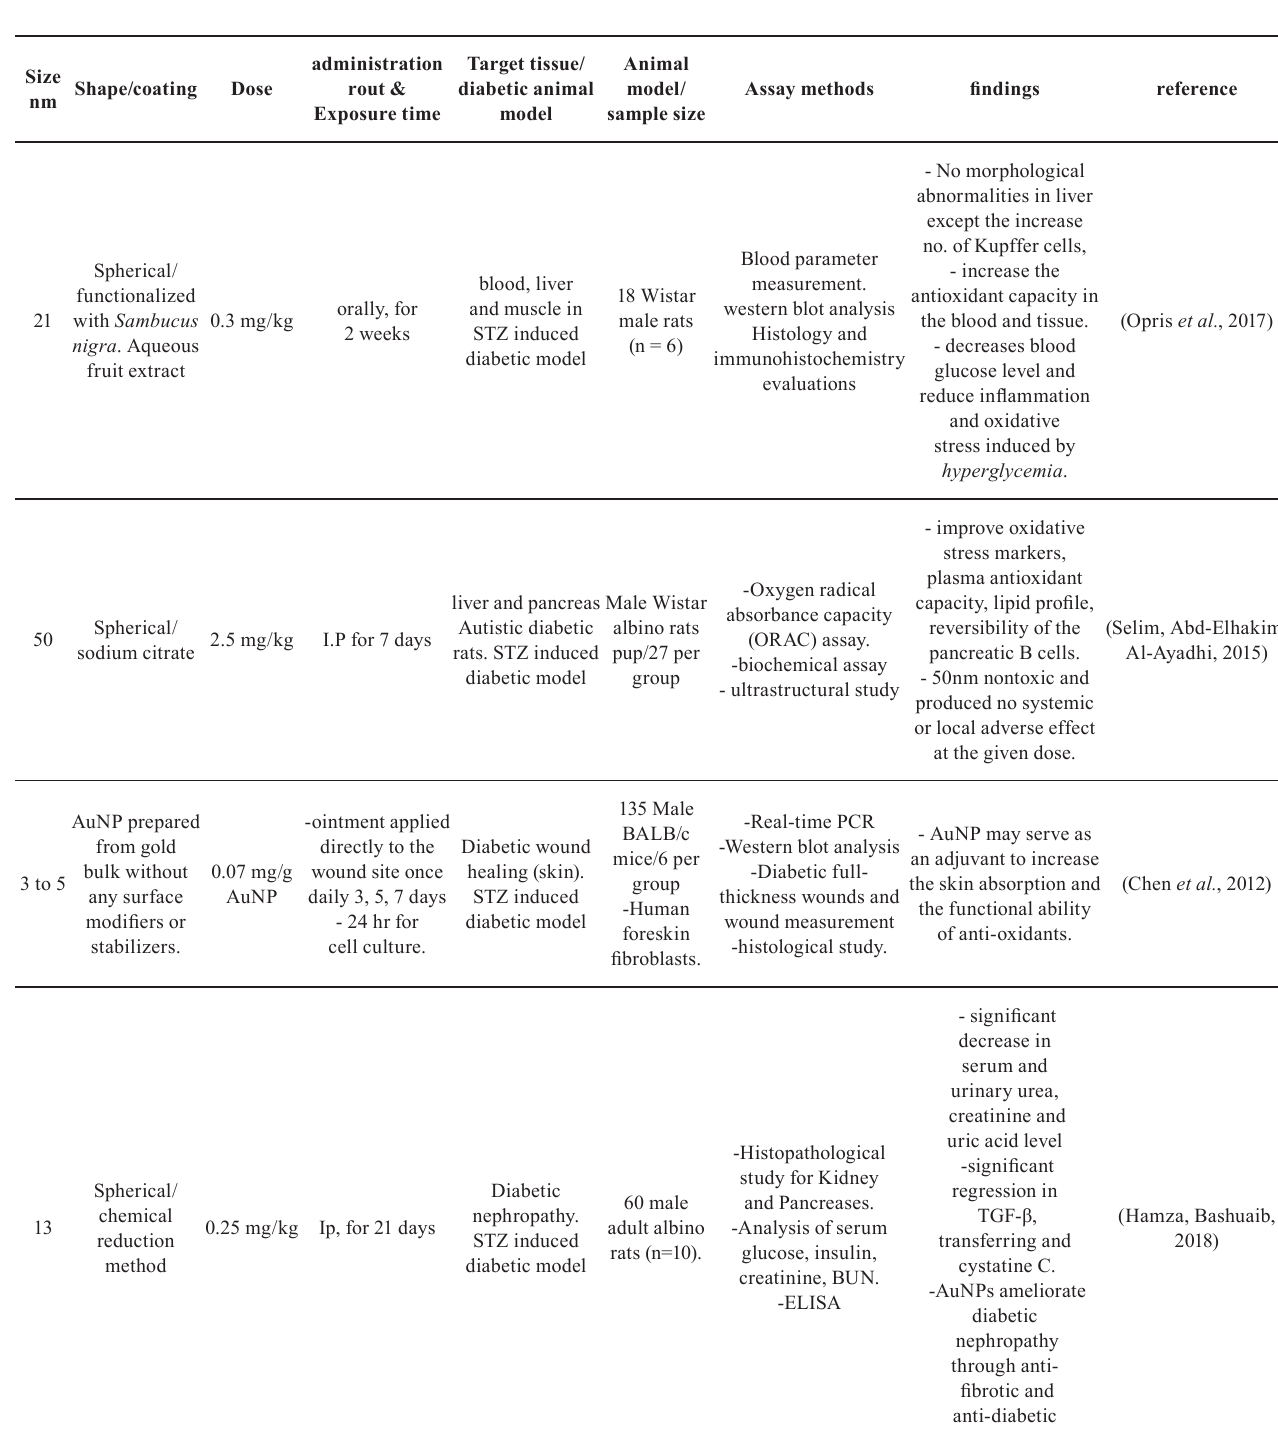
TABLE I – Therapeutic effects of Gold nanoparticles on diabetic animal models